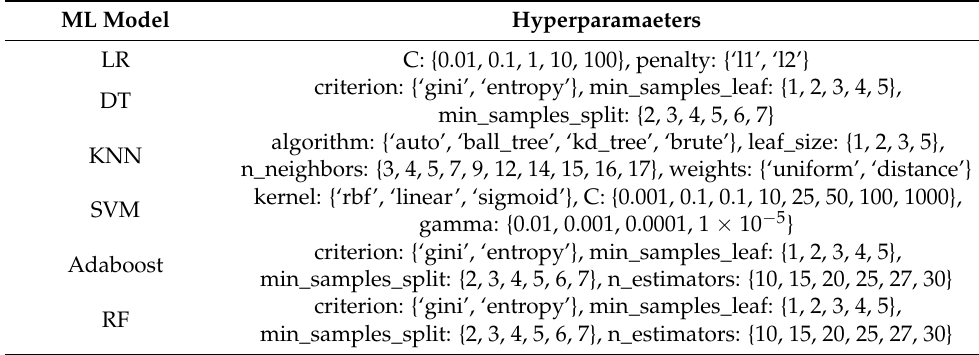
Table 2. ML hyperparameters tested in our